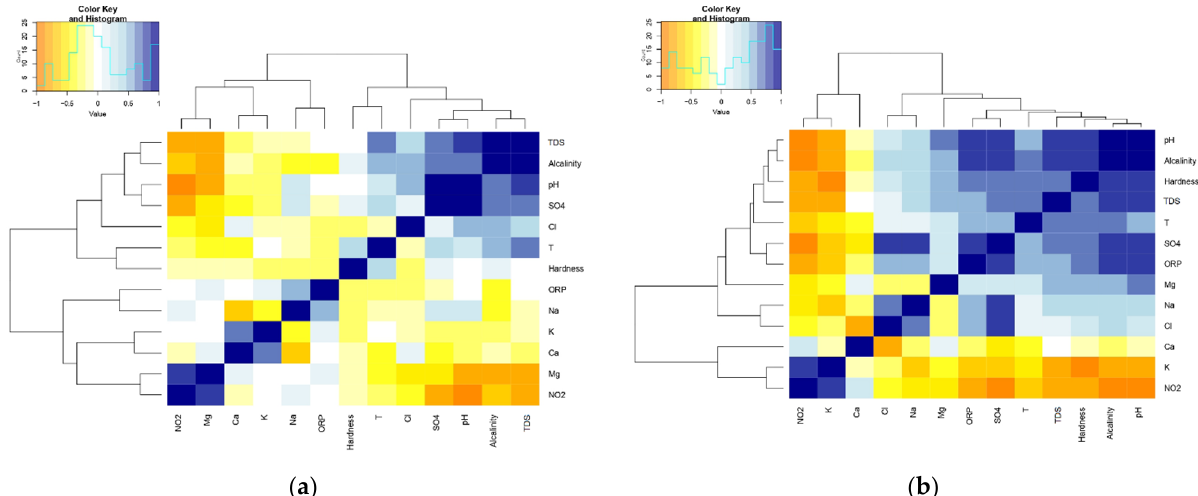
Figure 3. Heatmaps of physicochemical parameters for: ( a ) surface level and ( b ) deep level. The strength of color indicates the strength of correlation. Blue colors indicate positive correlations, light colors (yellow/orange) indicate negative correlations.